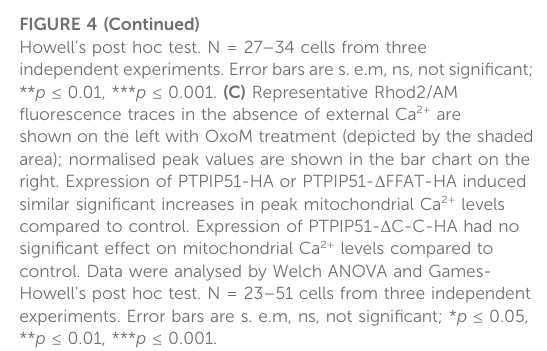
Howell ’ s post hoc test. N = 27 – 34 cells from three independent experiments. Error bars are s. e.m, ns, not signi fi cant; ** p ≤ 0.01, *** p ≤ 0.001. (C) Representative Rhod2/AM fl uorescence traces in the absence of external Ca 2+ are shown on the left with OxoM treatment (depicted by the shaded area); normalised peak values are shown in the bar chart on the right. Expression of PTPIP51-HA or PTPIP51- Δ FFAT-HA induced similar signi fi cant increases in peak mitochondrial Ca 2+ levels compared to control. Expression of PTPIP51- Δ C-C-HA had no signi fi cant effect on mitochondrial Ca 2+ levels compared to control. Data were analysed by Welch ANOVA and Games- Howell ’ s post hoc test. N = 23 – 51 cells from three